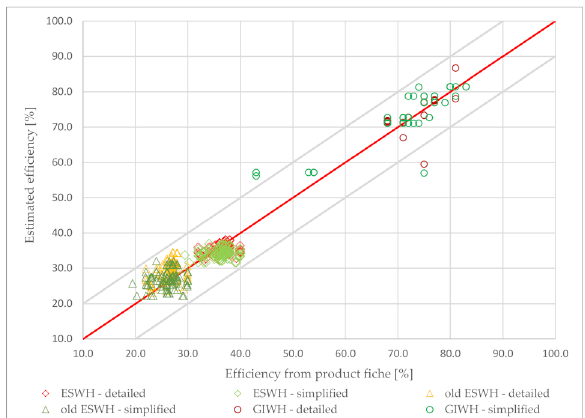
Figure 7. Comparison of water heater efficiency of simplified and detailed calculations and prod- uct